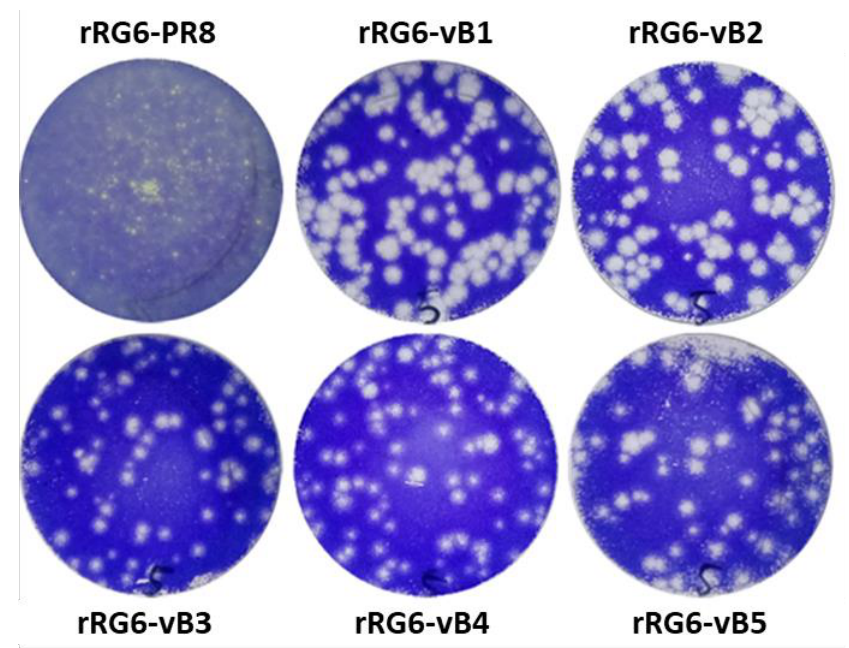
Figure 2. The plaque formation of reassortant viruses in Vero cells.